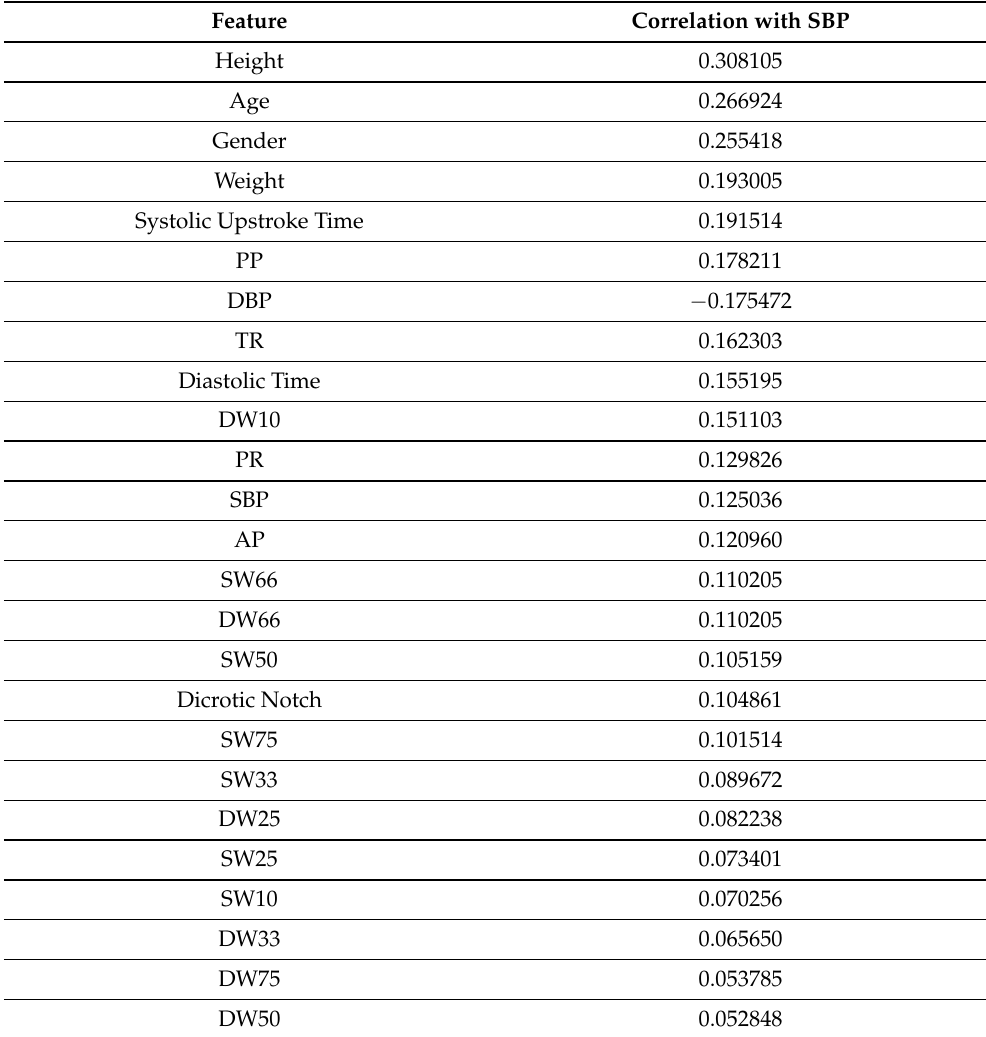
Table 9. Feature correlation for SBP